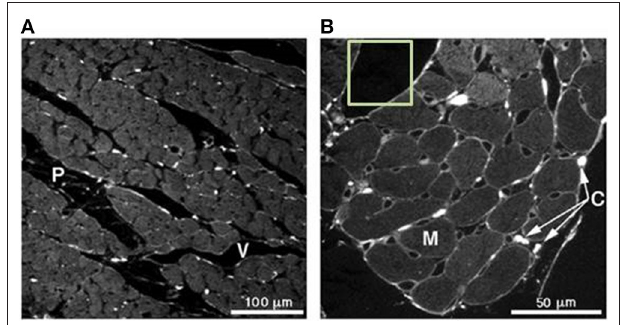
FIGURE 4 | (A) Slice taken from a mid-wall region of a rat’s left ventricle analyzed under a 25x magnification lens. (P) indicates the cleavage planes and (V) the vasculature structure. (B) 63x magnification of the same tissue in (A) . Here, the myocytes can be seen (M) and collagen chords in (C). Picrosirius red was used for the staining of collagen. Adjusted with permission from Young et al. (59).